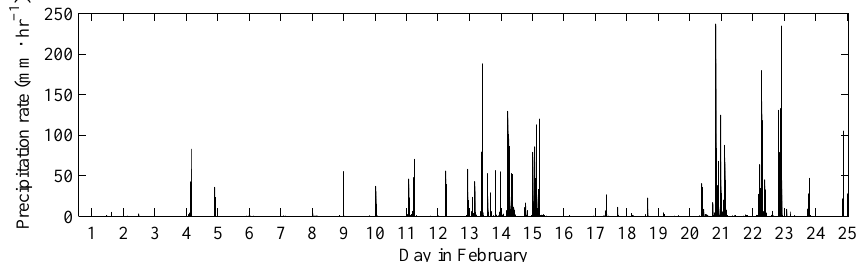
Figure 7. Time series of precipitation rate (in mmhr − 1 ) measured by an optical rain gauge at the Manus Island ARM site. Data courtesy of ARM archive.